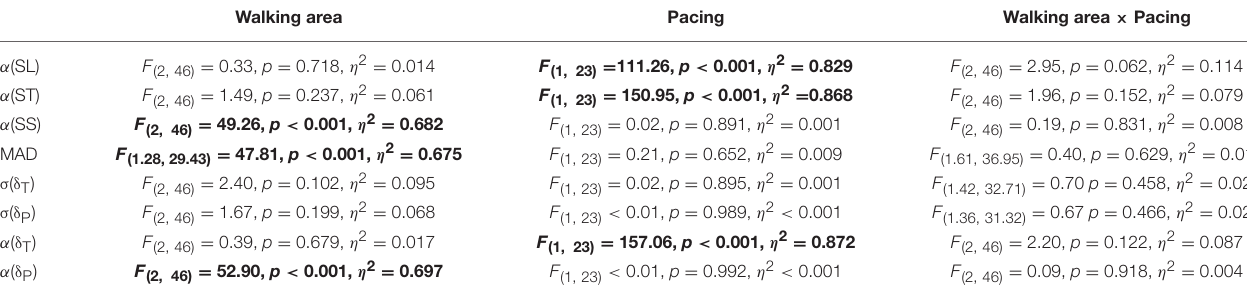
TABLE 1 | Main and interaction effects of the repeated-measures ANOVA with the factors Walking Area and Pacing for all dependent variables. Walking area Pacing Walking area × Pacing